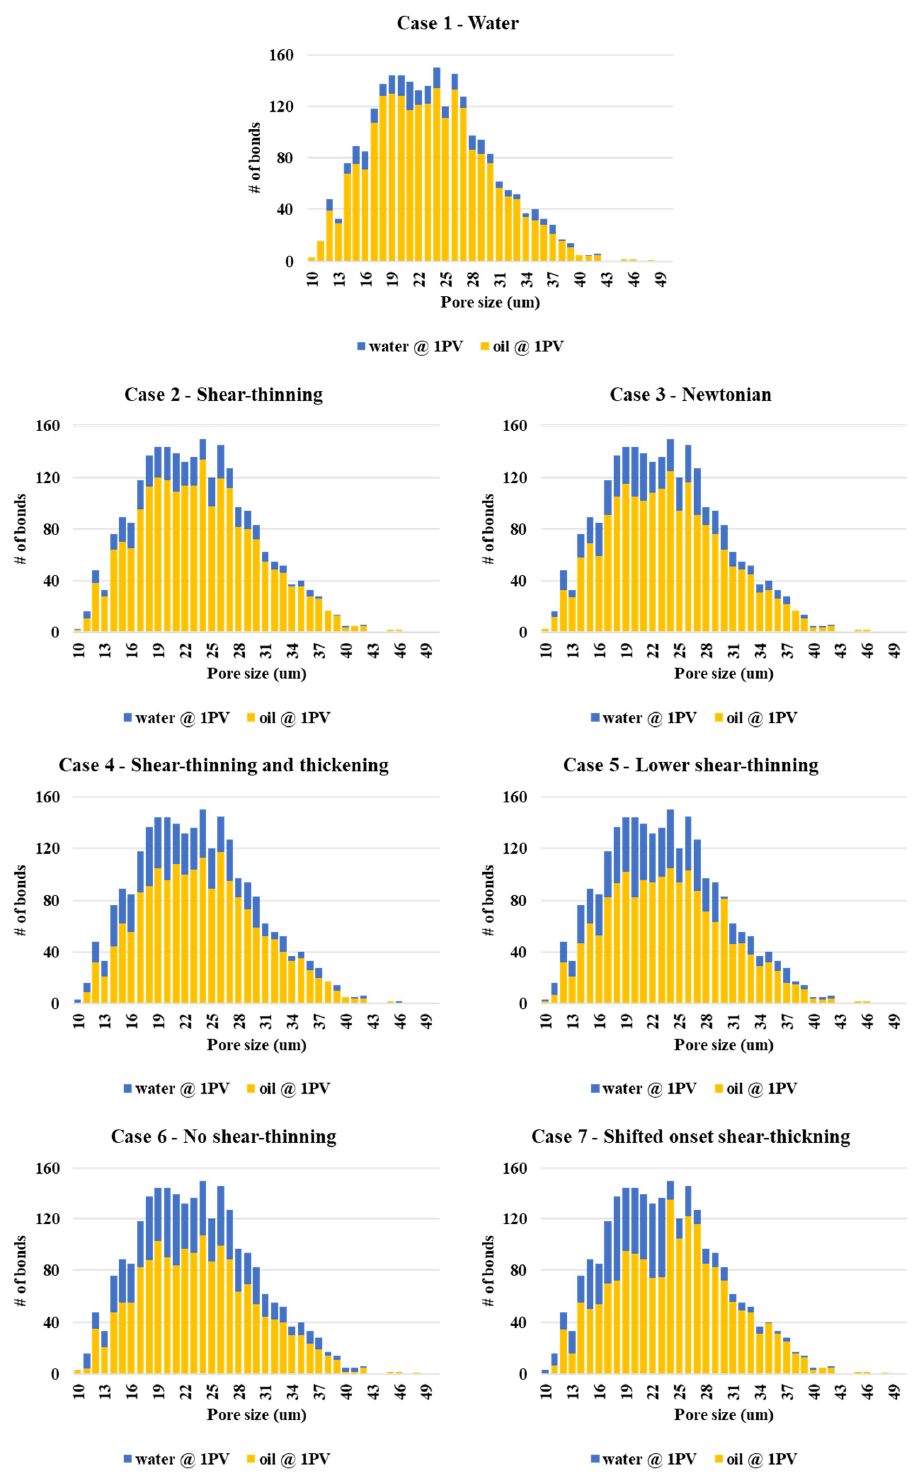
Figure 13. Polymer and water pore (bond) occupancy.